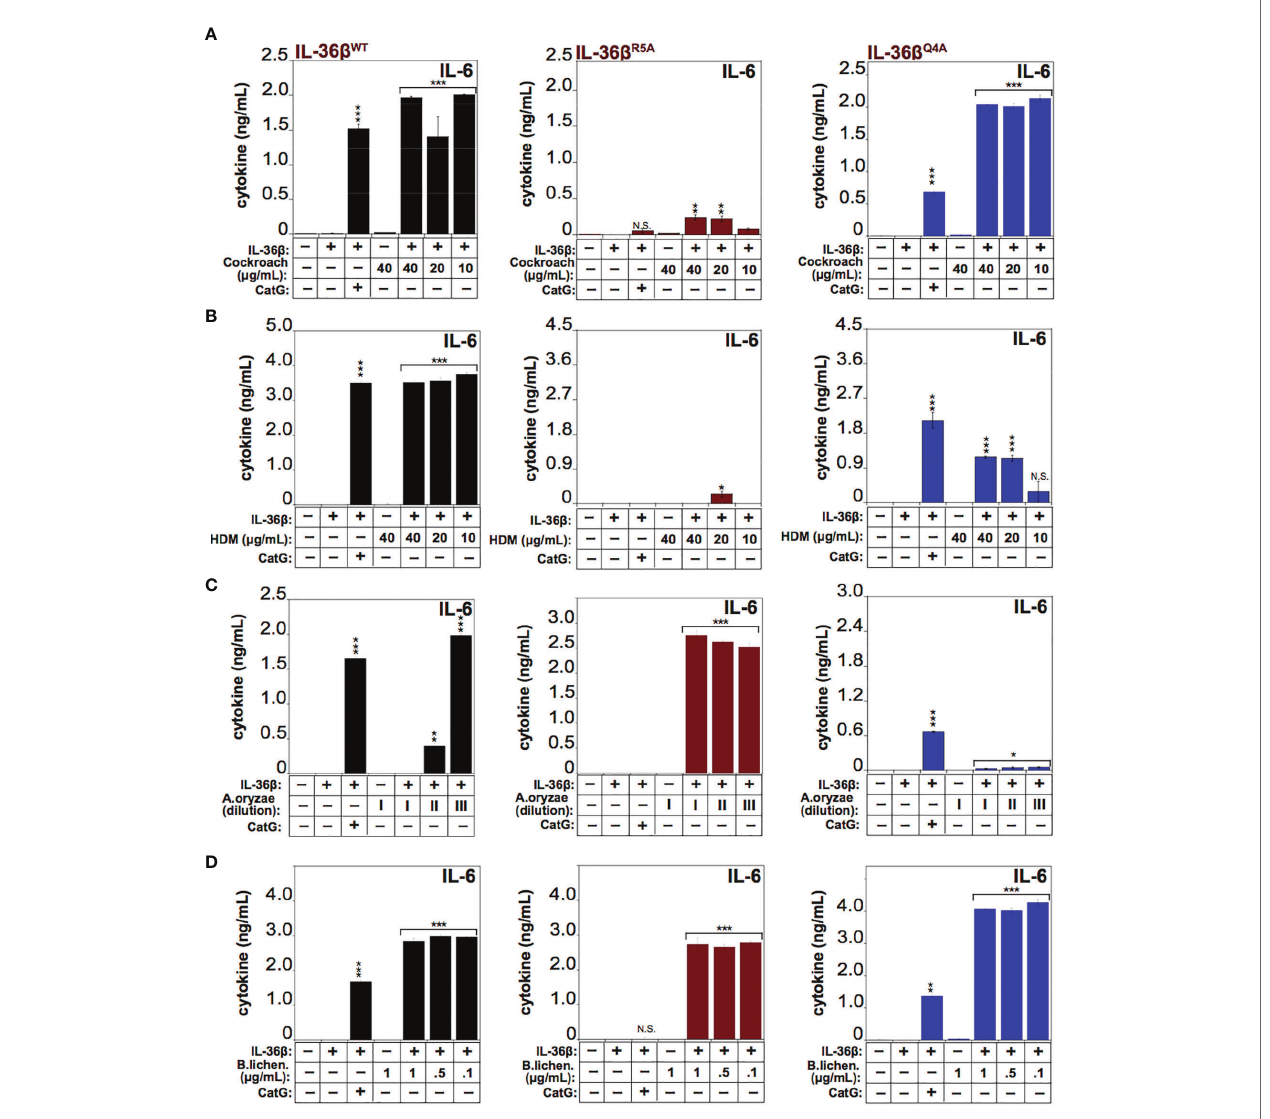
FIGURE 7 | IL-36 b point mutants resist activation by speci fi c allergens HeLa IL-36R cells were stimulated with 2 nM of wild type recombinant full length human IL-36 b , IL-36 b R5A , or IL-36 b Q4A , either untreated, or pre-incubated for 2 h at 37°C with a titration of 40, 20 and 10 m g/ml of extract from Cockroach (A) HDM (B), 1:2000, 1:10000 and 1:20000 dilutions from a stock of puri fi ed protease from A. oryzae (C) or 1, 0.5 and 0.01 m g/ml of B. licheniformis extract (D) . As a control, either wild type recombinant full-length human IL-36 b , IL-36 b R5A and IL-36 b Q4A cytokines were activated with 50 nM of cathepsin G. After 24h, IL-6 cytokine concentrations in cell culture supernatants were measured by ELISA. ***p < 0.001, **p < 0.01, *p < 0.1, Student ’ s t test. N.S., Not Signi fi